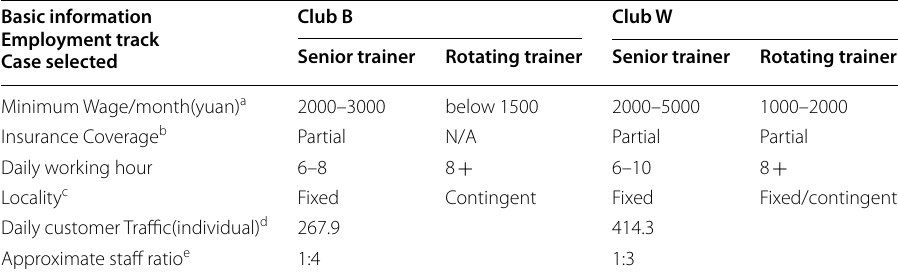
Table 1 Work condition of the dual